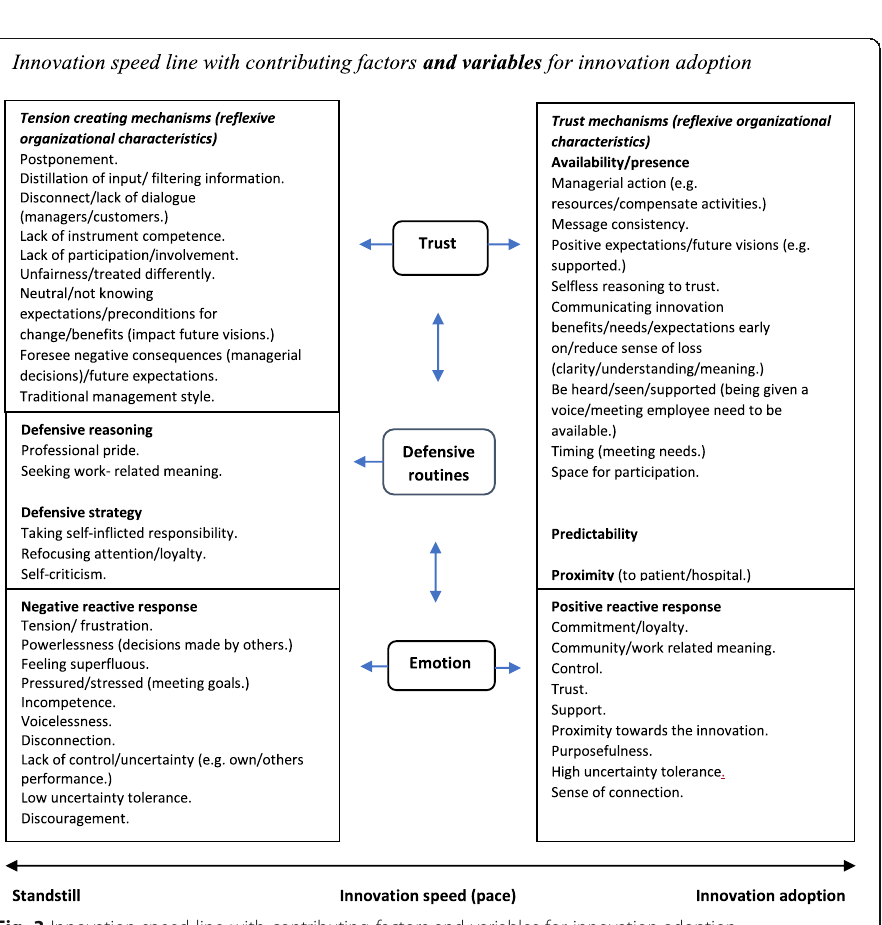
Fig. 3 Innovation speed line with contributing factors and variables for innovation